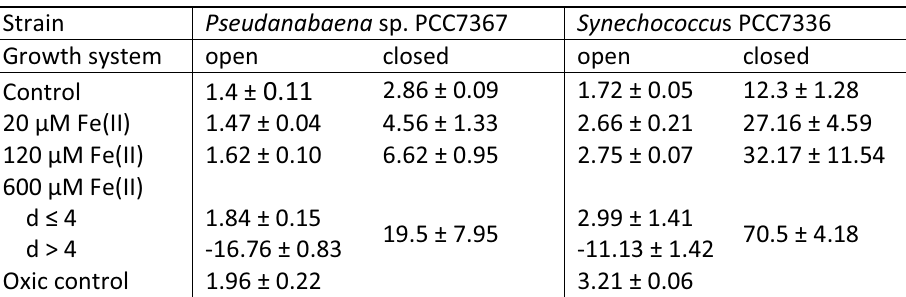
Fig. 2 Illustration of the effects of the addition of different concentrations of Fe(II) on the growth of Pseudanabaena sp. PCC7367 and Synechococcus sp. 7336. Comparison of growth ( a , b , e ) and Fe(II) oxidation ( c , d ) of Pseudanabaena sp. PCC7367 ( a , c ) and Synechococcus sp. PCC7336 ( b , d ) between the open- and a closed-culture systems. The growth response of the two strains of saltwater Cyanobacteria in 22 mM NaHCO 3 -buffered ASN-III media to different concentrations of Fe(II) was measured by Chl a determination every 2 – 3 days ( a , b ) for 21 days in closed anoxic culture bottles (solid lines) or open cell suspension fl asks in an anoxic workstation (dashed lines). The Fe(II) starting concentrations were 20 µ M (PCC7367 light green/PCC7336 yellow), 120 µ M (PCC7367 green/PCC7336 orange) and 600 µ M (PCC7367 dark green/PCC7336 red). The controls (grey) were grown in ASN-III media with an Fe(III) concentration of 15 µ M under anoxic (solid/dashed line) and normal atmospheric conditions (dotted line). The oxidation of Fe(II) to Fe(III) was assessed in parallel using a spectrophotometric assay ( c , d ). Fe(II) measurements of abiotic controls are depicted in Supplementary Fig. 6. Cell doubling times ( d ) and their standard deviations during the exponential growth phase ( e ) were determined from day 1 to 13 for Pseudanabaena sp. PCC7367 and from day 1 to 17 for Synechococcus sp. PCC7336. The doubling time for the cultures with 600 µ M Fe(II) in the open-culture system was split into a doubling time before green rust formation at day 4 and after. Data are presented as mean values ± SD with n = 4 biologically independent samples. Asterisks (*) represent a signi fi cant difference to the media control grown in the equivalent growth system ( p < 0.05, Student ’ s t -test,